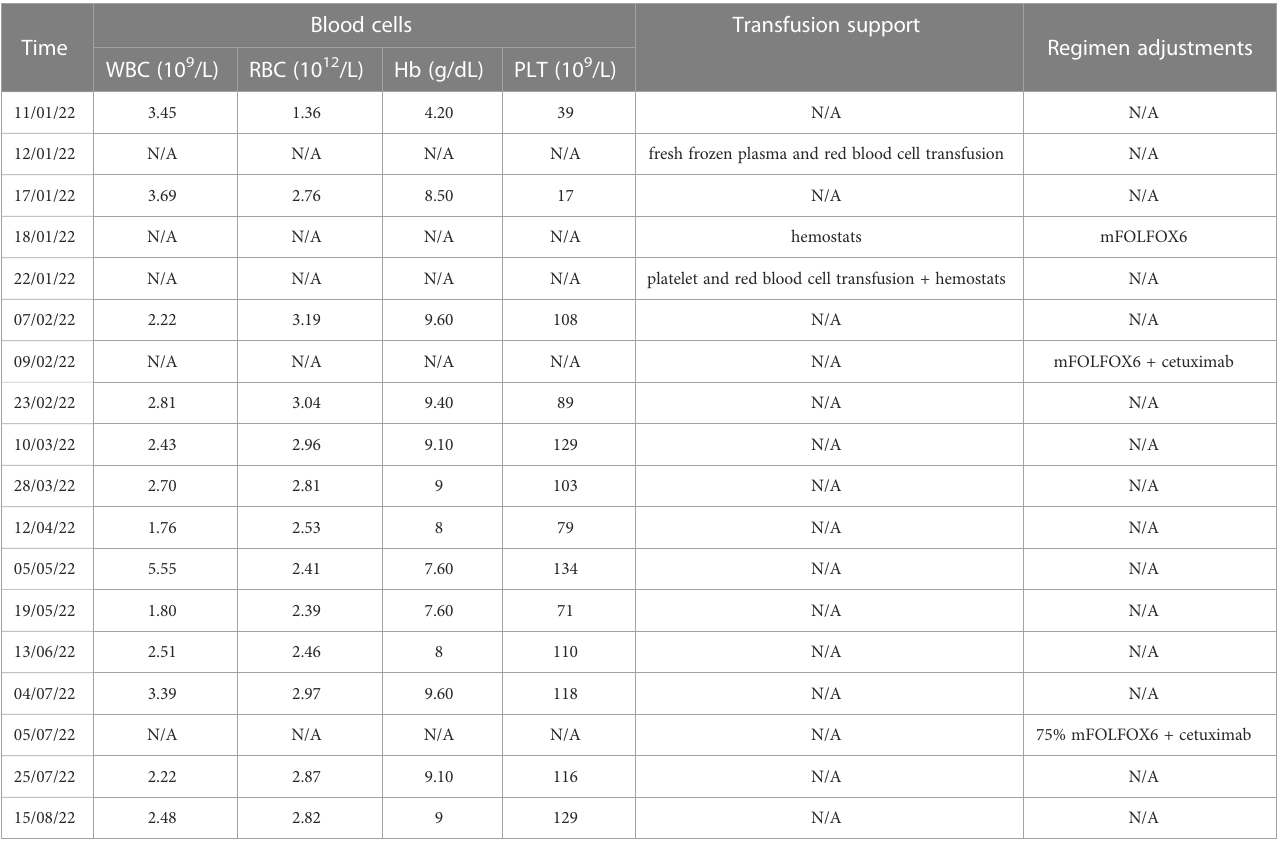
TABLE 1 A summary of blood cell counts and